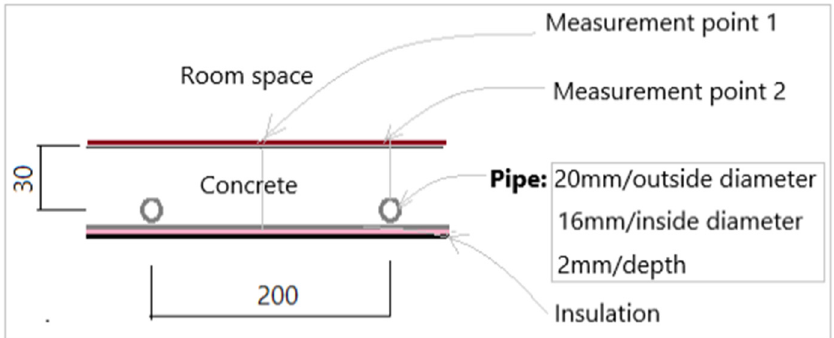
Figure 3. The section of the radiant cooling and heating pipe installation plan.